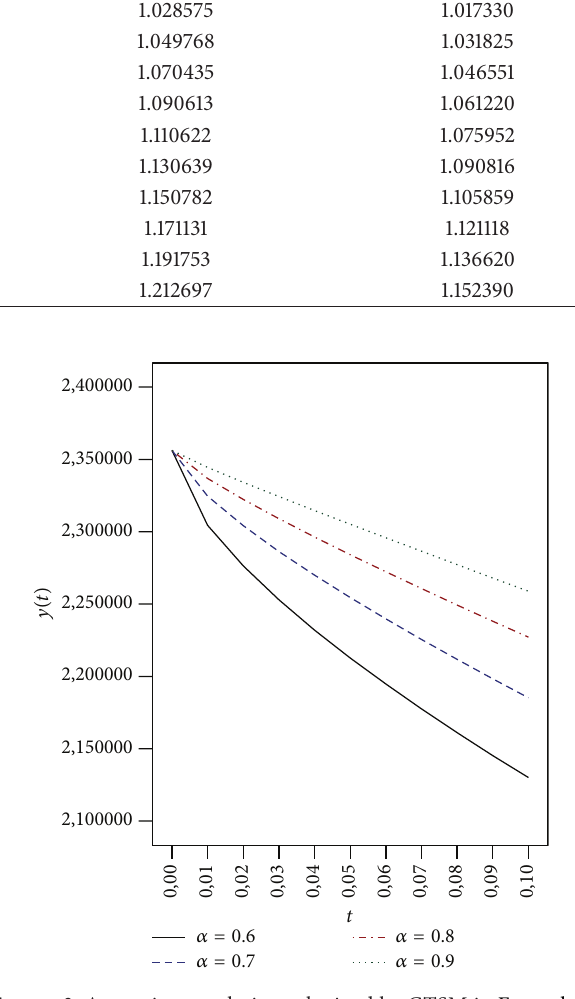
Figure 3: Approximate solutions obtained by GTSM in Example 3 for different order of